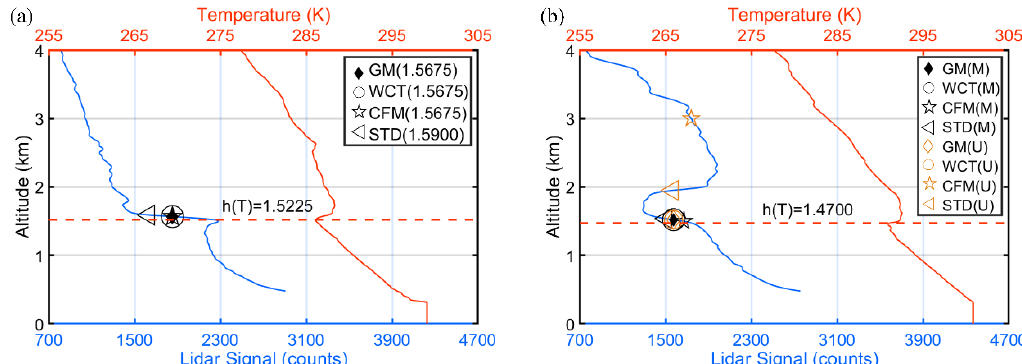
Figure 5. Vertical profiles of lidar RCS (blue line) and temperature (red line) at the SGP site. The profiles were observed ( a ) at 11:30 LT on 30 August 2017 (single aerosol layer) and ( b ) at 17:30 LT on 23 August 2017 (double aerosol layers), respectively. The planetary boundary layer height (PBLH) determined using four lidar methods are marked in different sharps. The red dashed horizontal line shows the PBLH determined by temperature-gradient. h(T) is the PBLH determined by temperature-gradient. M stands for maximum limited height initialization and range restriction (MLHI-RR) and U stands for unlimited in Figure 4b.